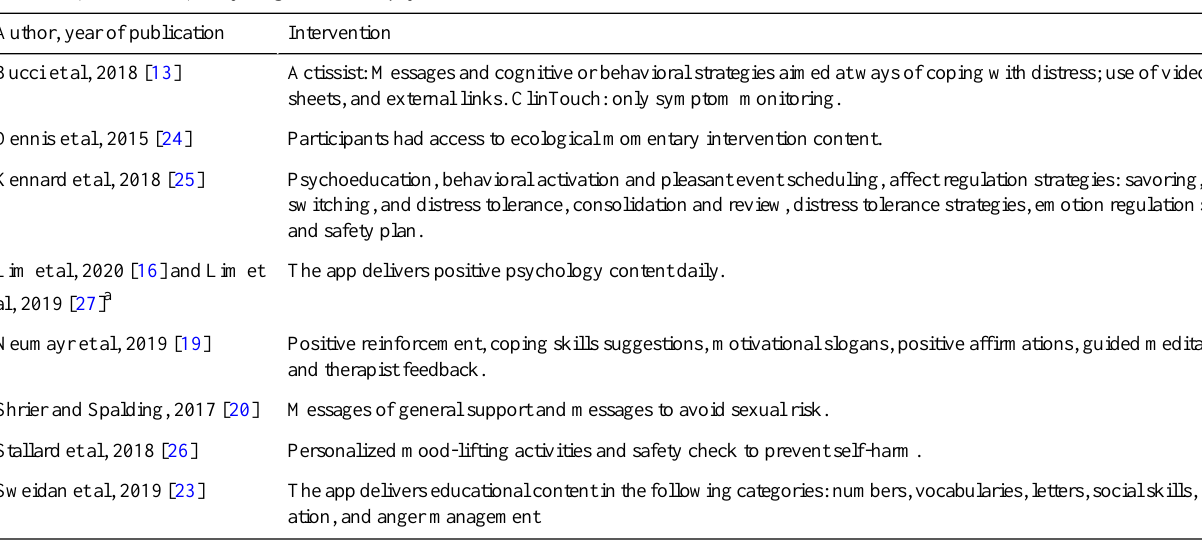
Table 4. Description of the treatments delivered by the apps in studies on self-monitoring and automatically generated data collected via smartphones in children, adolescents, and young adults with psychiatric disorders